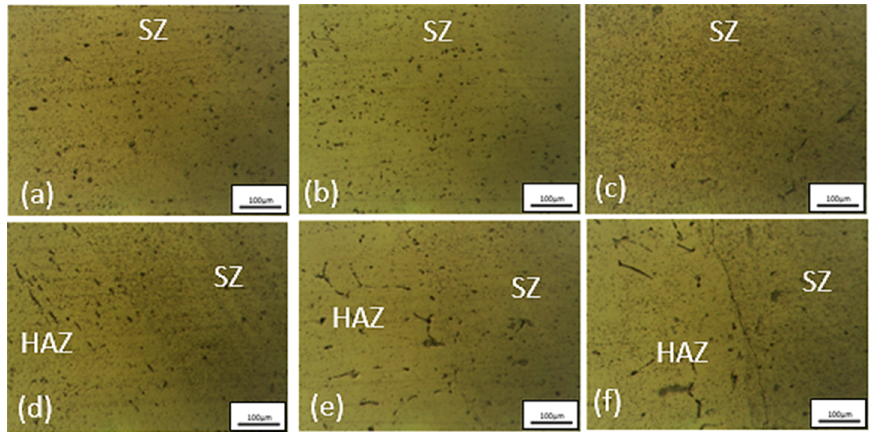
Figure 28. Microscopy images of SZ at, ( a ) 20 mm/min, ( b ) 25 mm/min, ( c ) 30 mm/min and HAZ-SZ boundary at ( d ) 20 mm/min, ( e ) 25 mm/min, and ( f ) 30 mm/min.